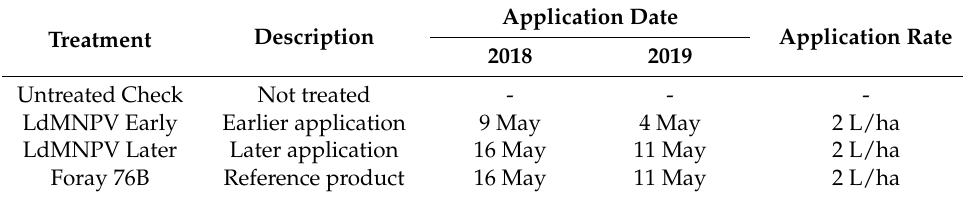
Table 1. Treatments in the time–response trial.